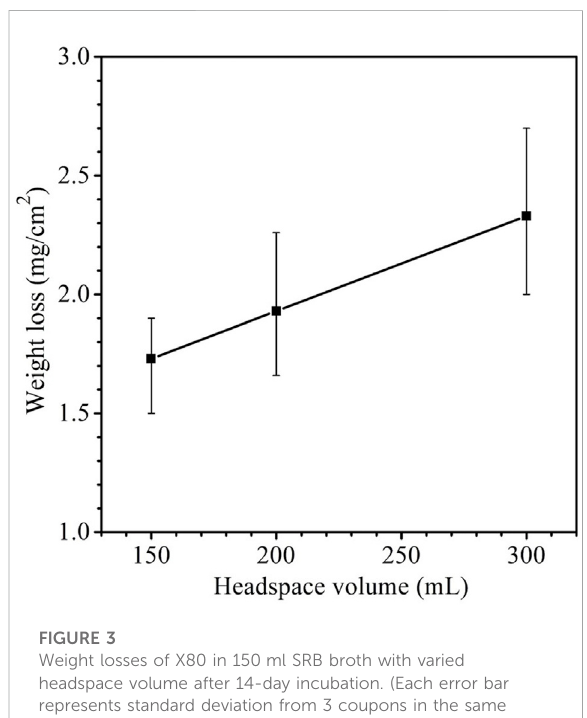
FIGURE 3 Weight losses of X80 in 150 ml SRB broth with varied headspace volume after 14-day incubation. (Each error bar represents standard deviation from 3 coupons in the same anaerobic